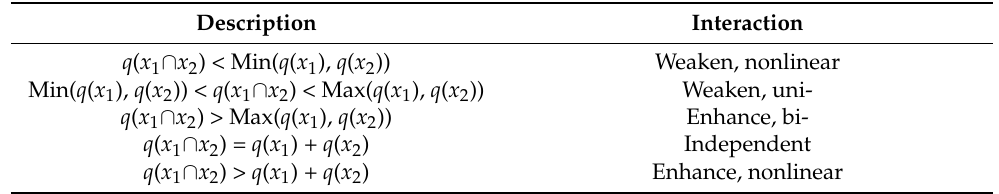
Table 3. Types of two-factor interaction of interaction detection.